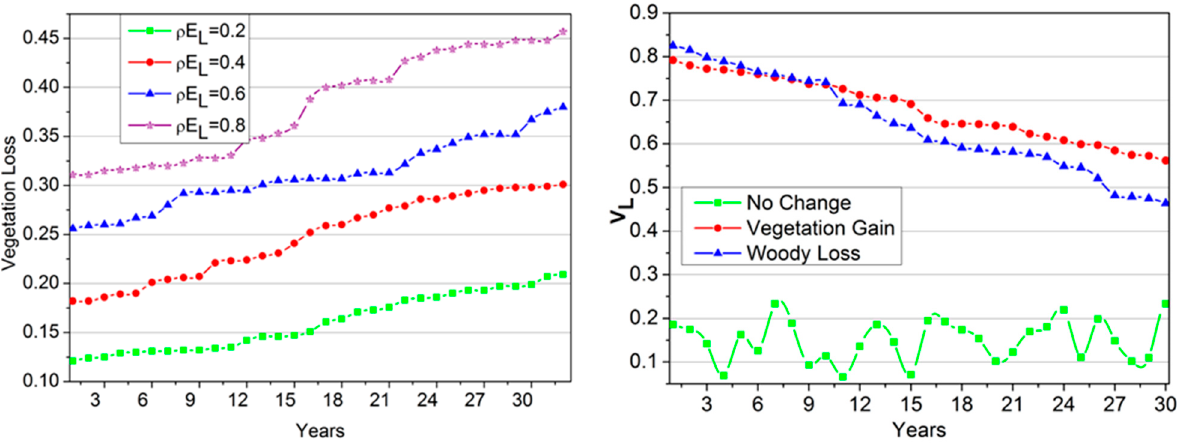
Figure 8. Vegetation loss and V (cid:2896) analysis.